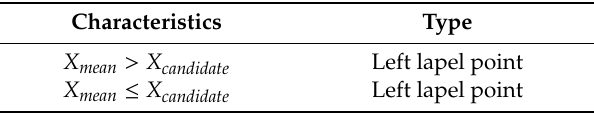
Table 3. The type of lapel points in a picture skyline.